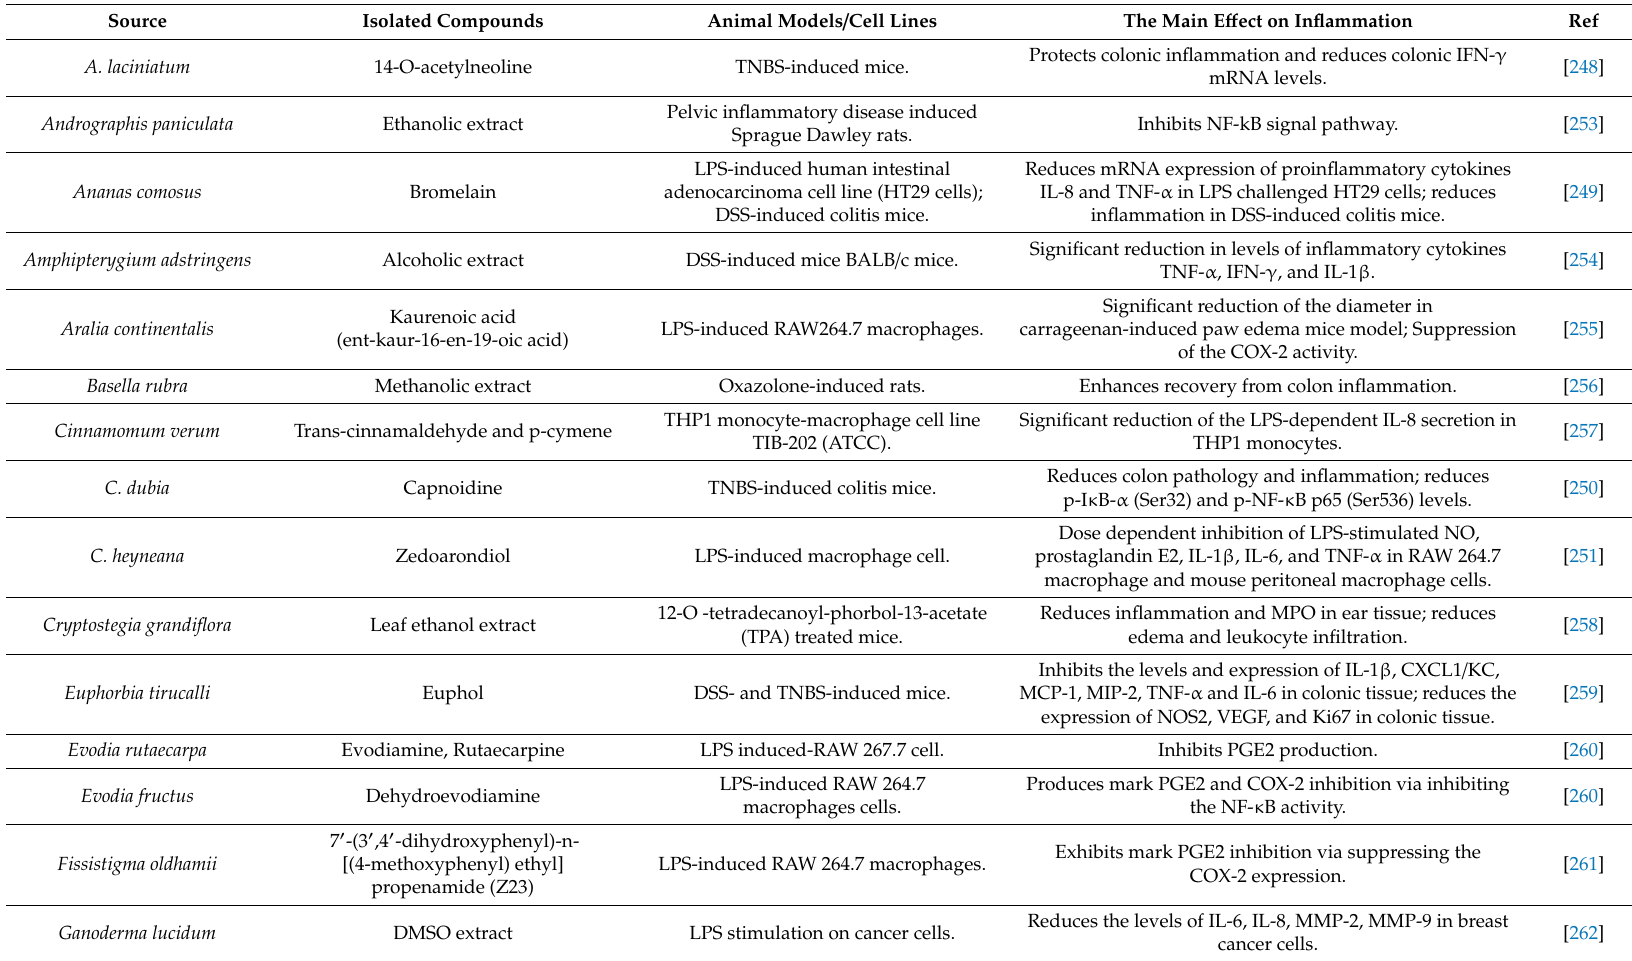
Table 3. Natural products showing protective functions in various animal colitis models / cell